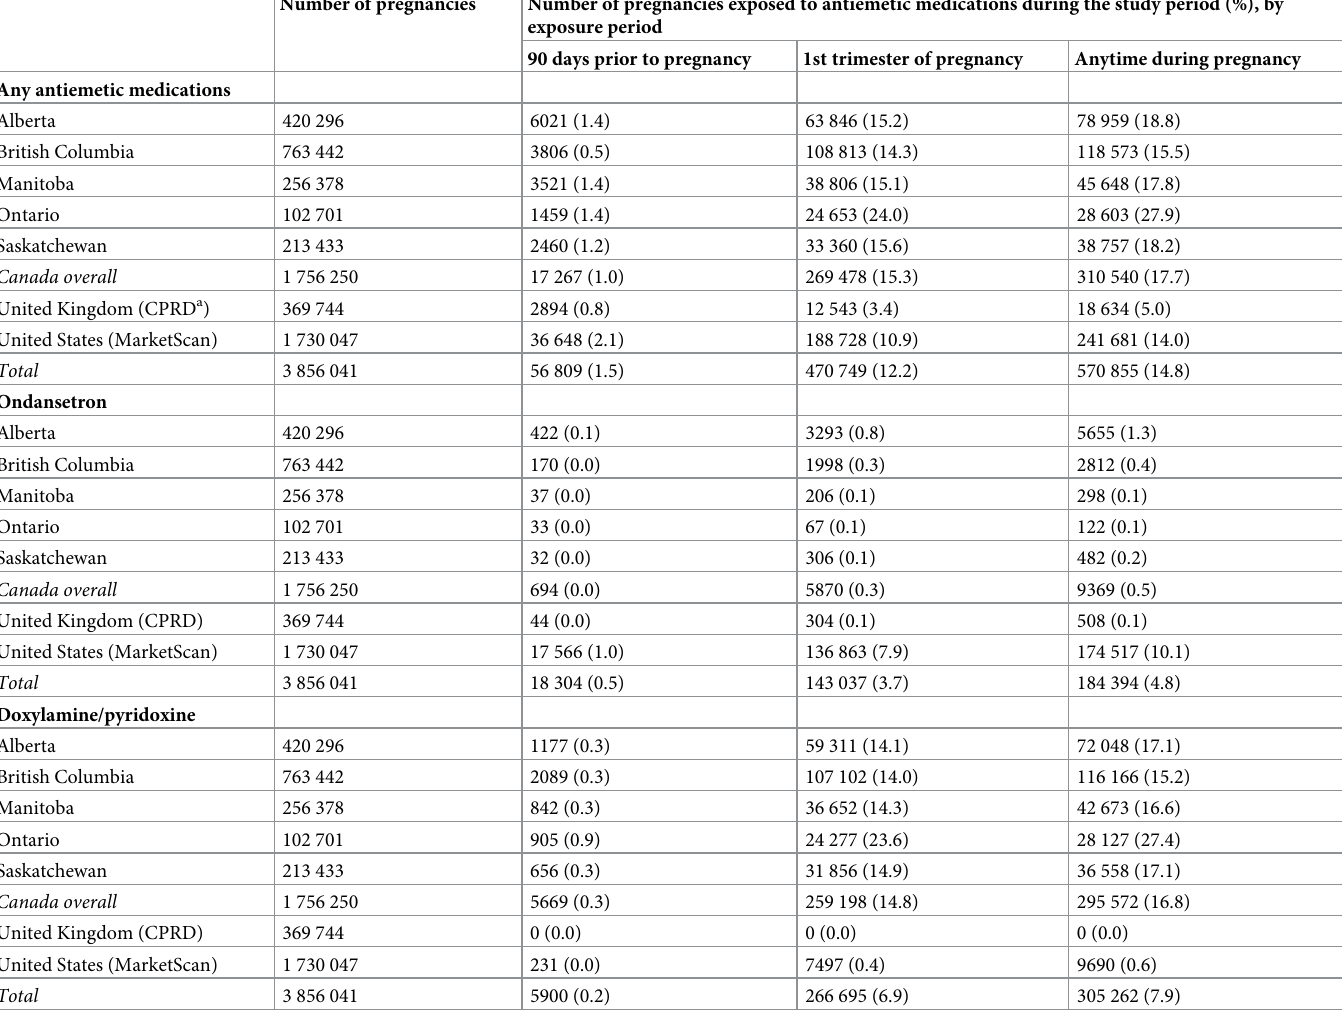
Table 2. Use of antiemetic medication before and during pregnancy, by study site. Number of